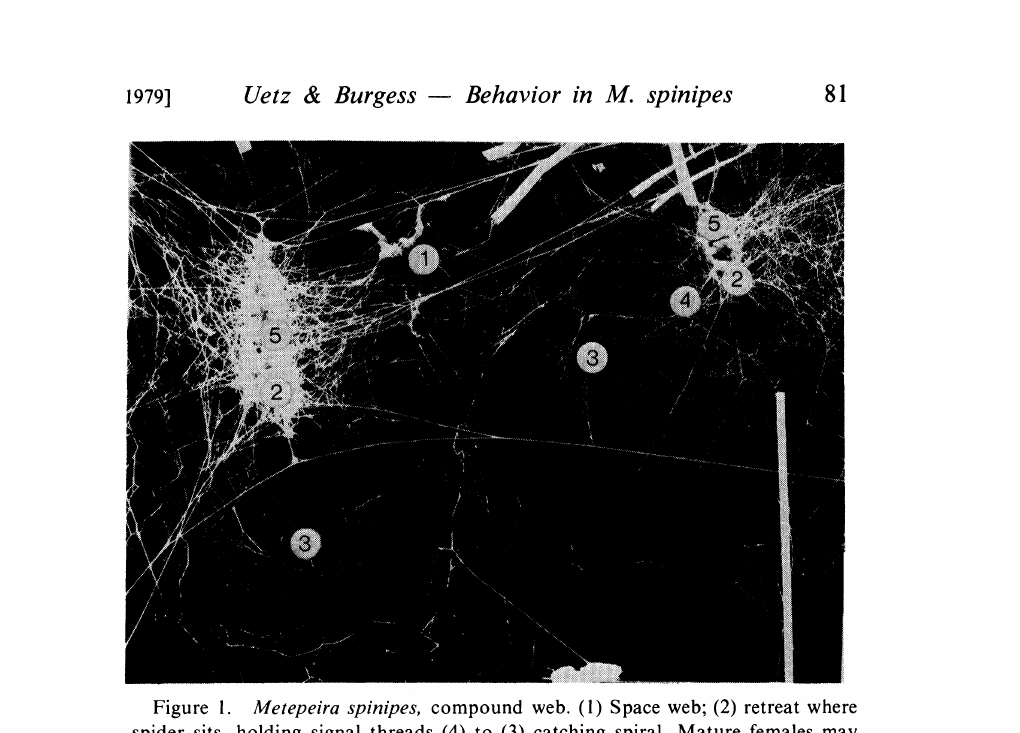
Figure 1. Metepeira spinipes, compound web. (1) Space web; (2) retreat where spider sits, holding signal threads (4) to (3) catching spiral. Mature females may construct tiers of egg sacs (5). [Courtesy of Dr. Peter N. Witt, North Carolina Division of Mental Health and Mental Retardation Services. Used with